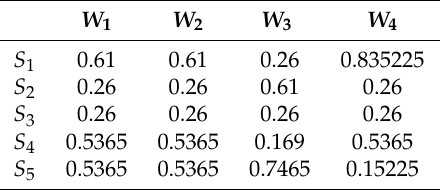
Table 5. The weighting of the objective function in linguistic values.